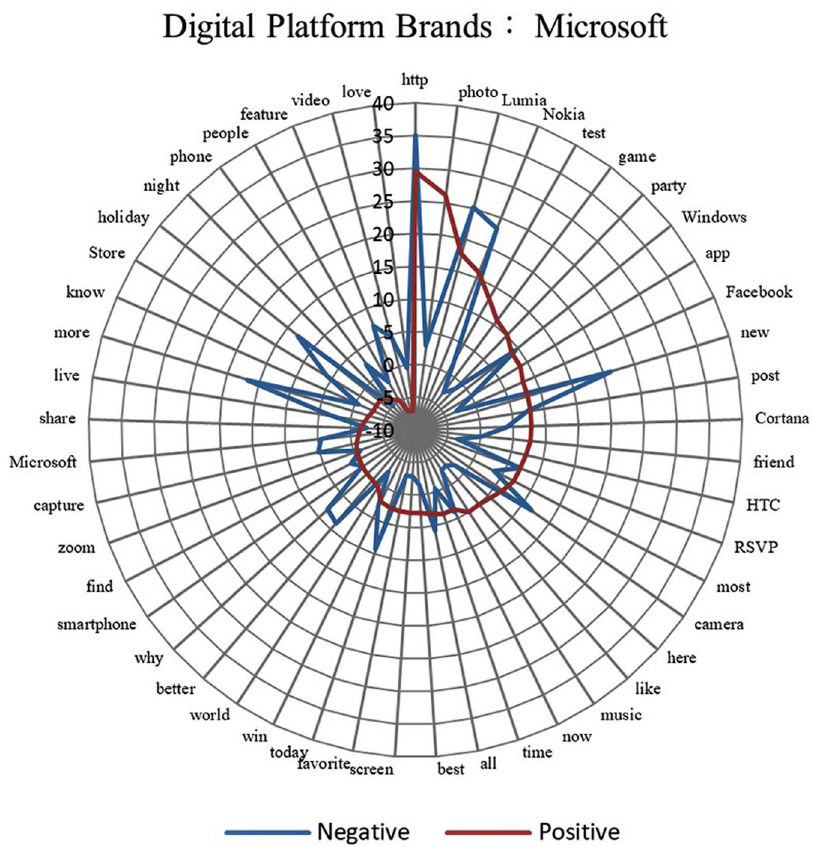
Fig. 8 Cues of Microsoft, positive and negative clues in the postings on the “ Microsoft ” fan